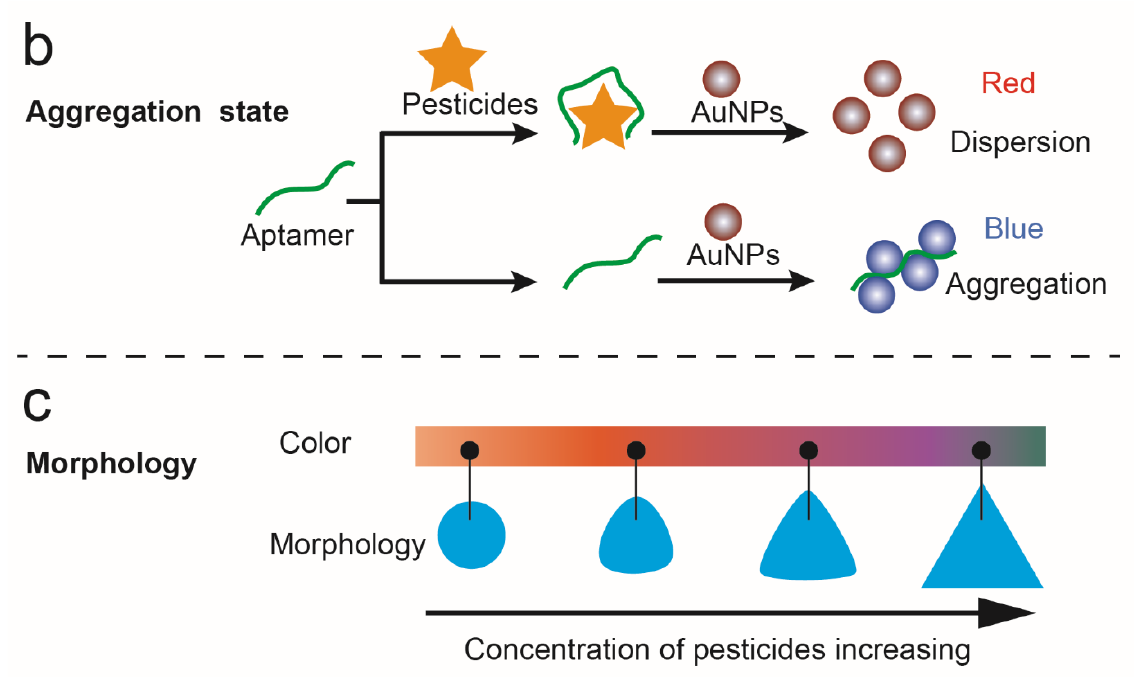
Figure 2. Detection of pesticides based on the unique and variable color of nanoparticles. ( a ) Illus- tration of the lateral flow immunoassay based on the use of gold nanoparticles for simultaneous detection of three pesticides [17]. ( b ) A schematic illustration of the aptamer-based colorimetric sensing of acetamiprid [21]. ( c ) The mechanism of anti-etching colorimetric detection based on TSNPs for thiram residues in soil [23].